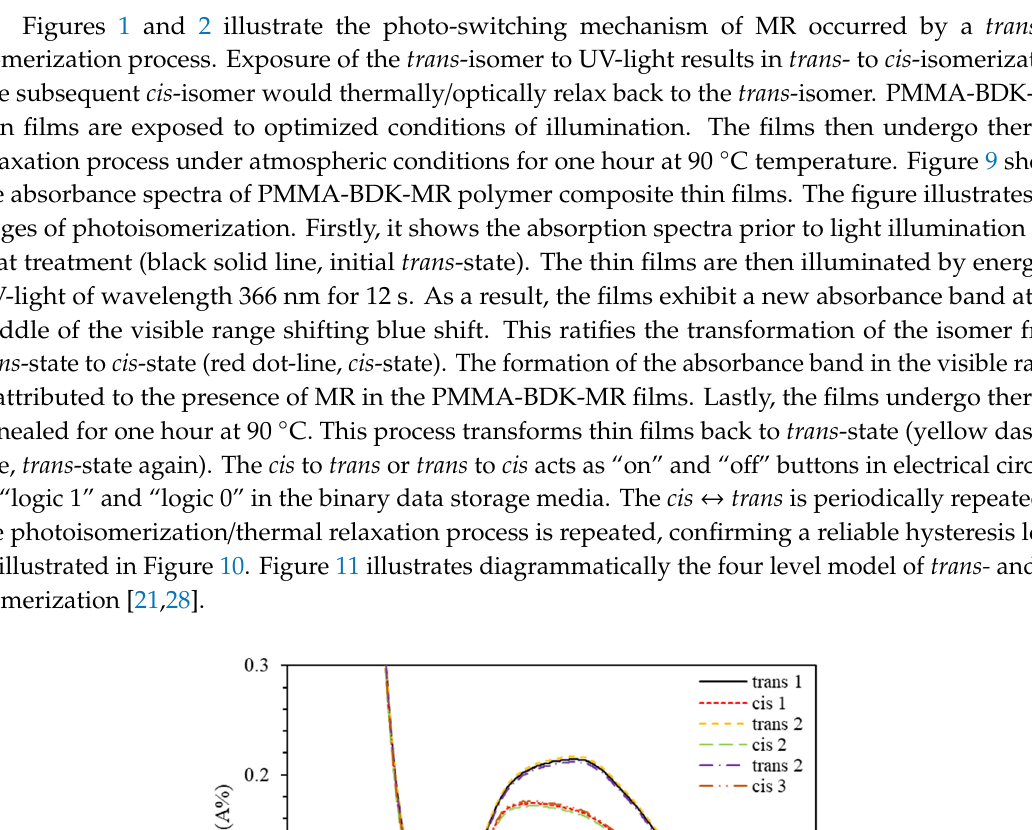
Figure 10. Maximum absorbance values through photochemical and thermal processes that transforms from trans to cis and vice versa of PMMA-BDK-MR polymer composite thin films.